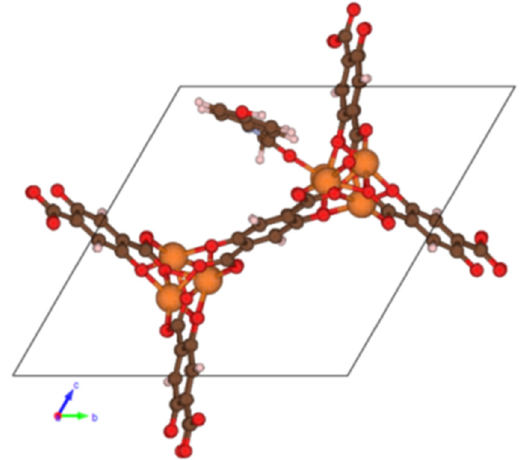
Figure 2. Projection of the CPO-27-Mg cell with paracetamol, no solvent is shown.